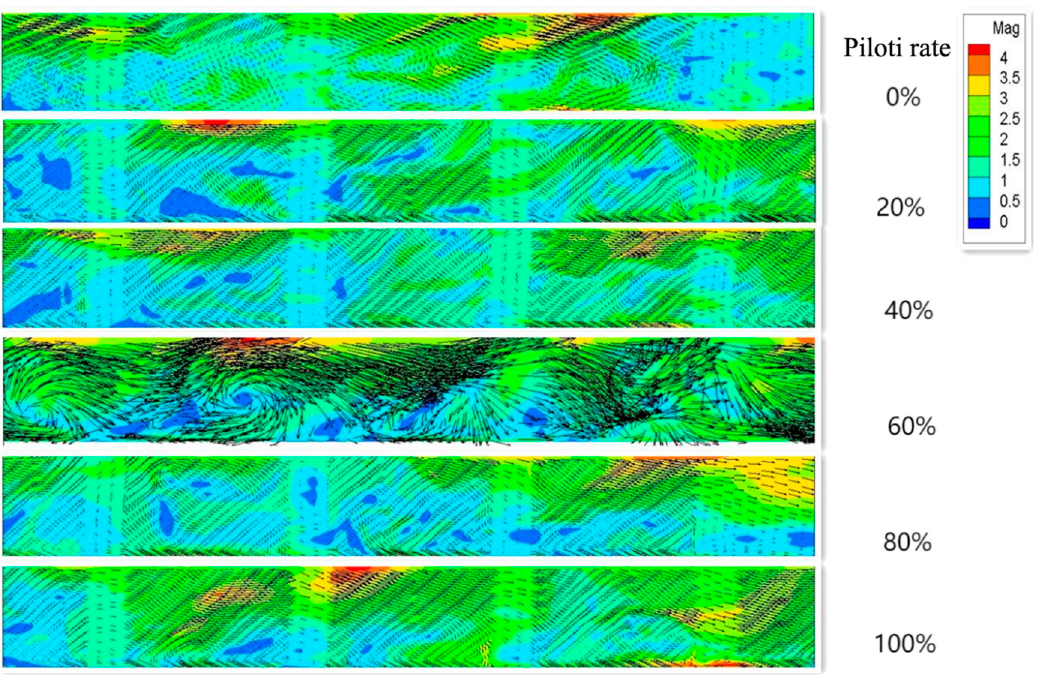
Figure 10. Vector diagram of the target area of Section 2 (Determinant model).